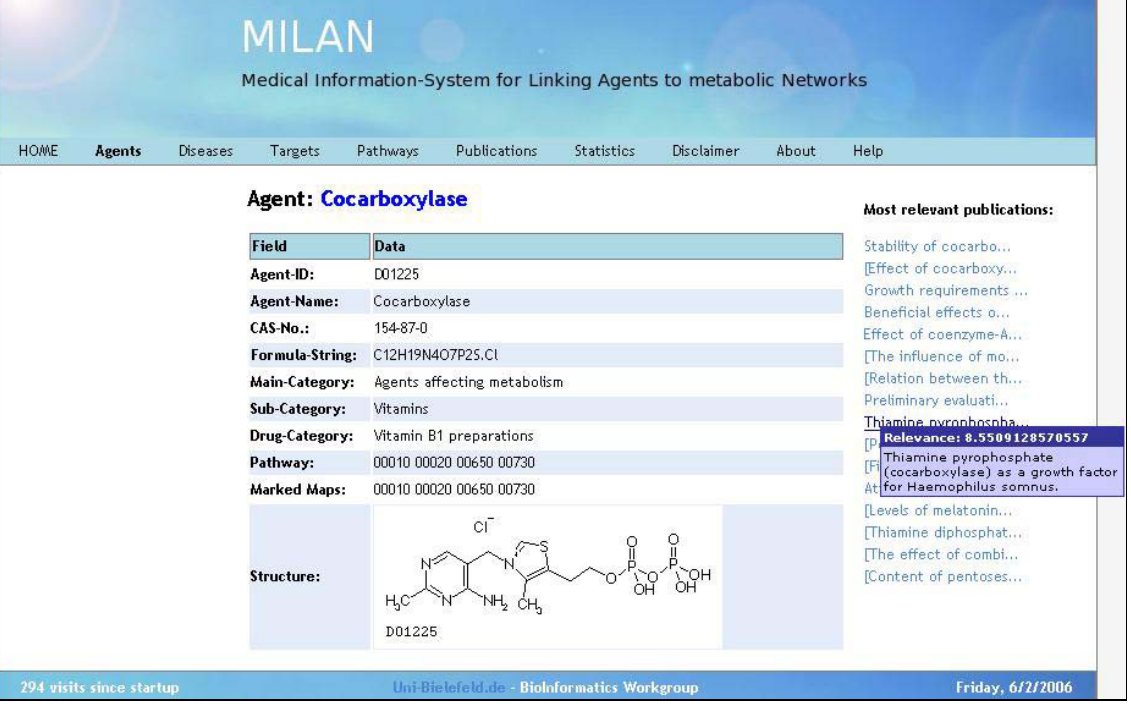
Figure 5: The figure shows the MILAN-webfrontend while displaying the dataset for a selected agent (cocarboxylase). In the middle of the screen we see information about the agent and links to marked pathway maps as well. By clicking these links the user will see a generated pathway- map with the highlighted agent-molecule (Figure 6). On the left side a list of the most relevant papers about this agent is